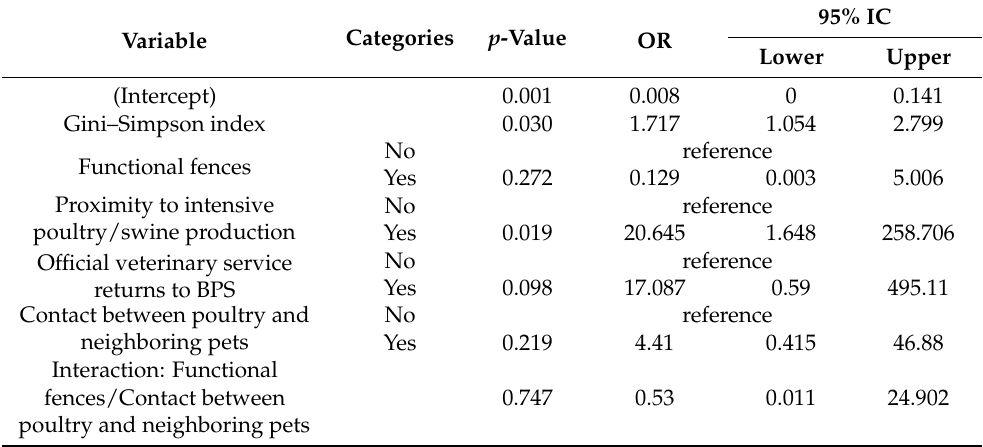
Table 6. Final model results from the multivariable logistic regression analysis. The p -value, odds ratio (OR) and 95% confidence interval (C.I.) with lower and upper limits are reported for risk factors associated with positivity to STEC in